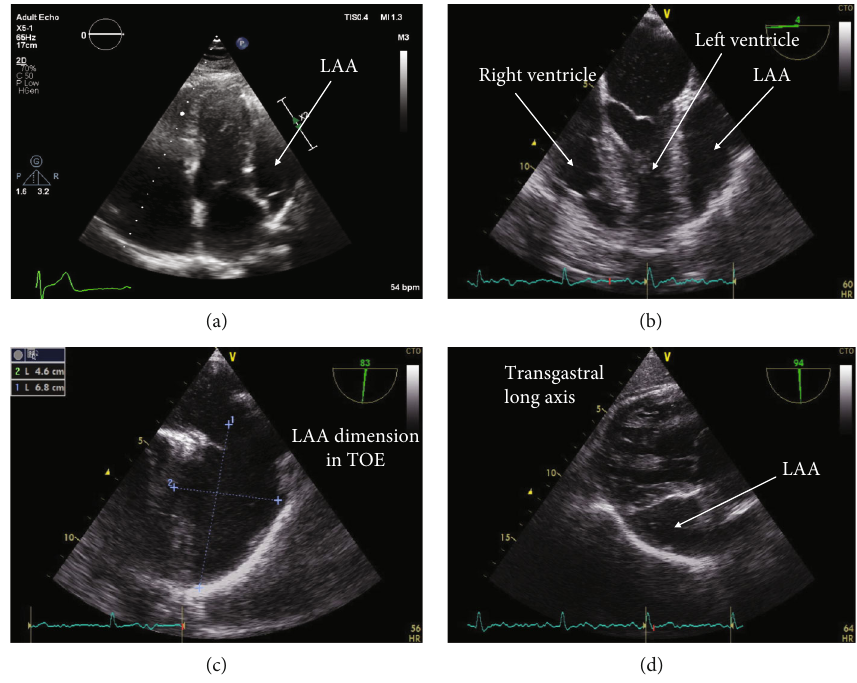
Figure 1: Echocardiographic views of the LAA.